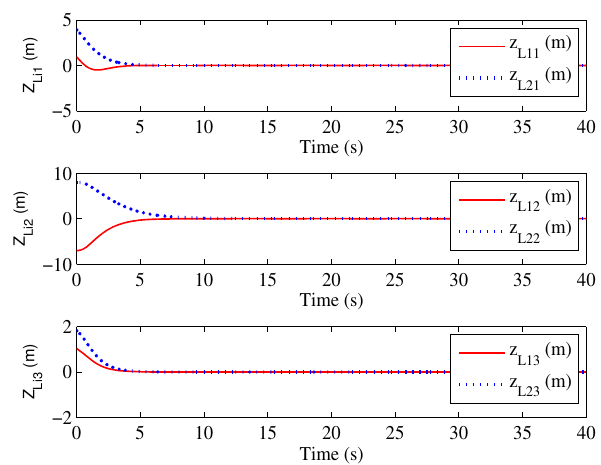
Figure 5. Positions of the leader and followers.